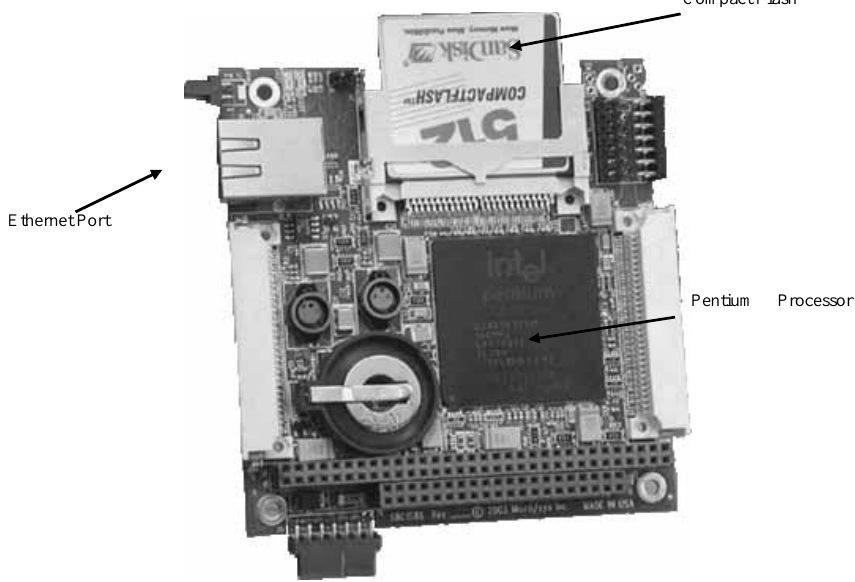
Fig. 4. Single board computer (actual size) showing the processor, the compact flash drive, and Ethernet